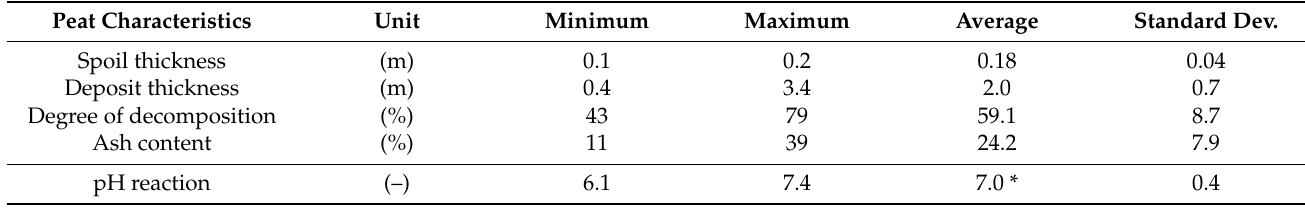
Table 1. Parameters of the peat deposit in